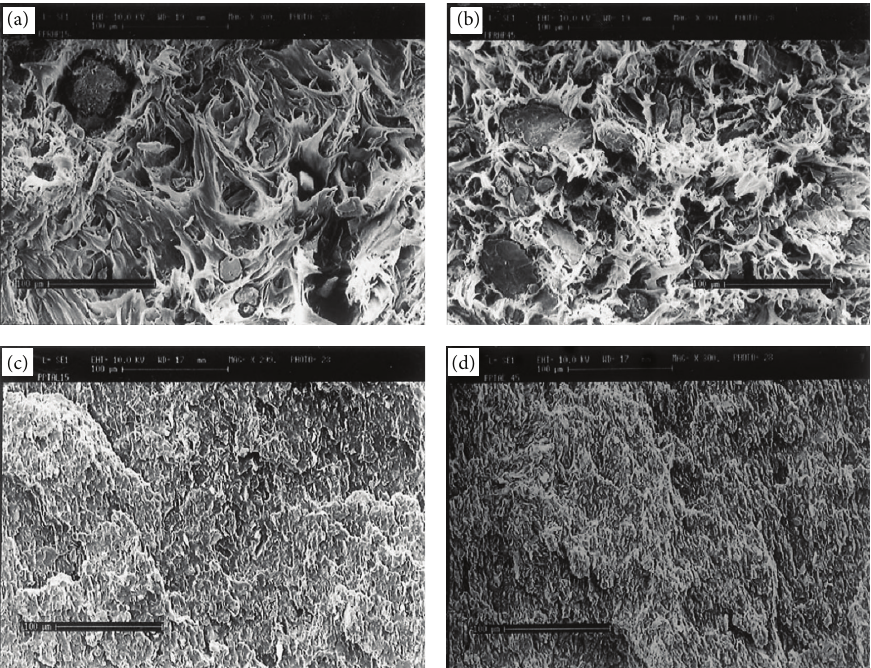
Figure 20: SEM micrographs of the tensile fracture surface of (a) and (b) PP/RHP composites and (b) and (c) PP/talc composite at 15 and 45 php of fillers content, respectively (mag. × 300) [21].